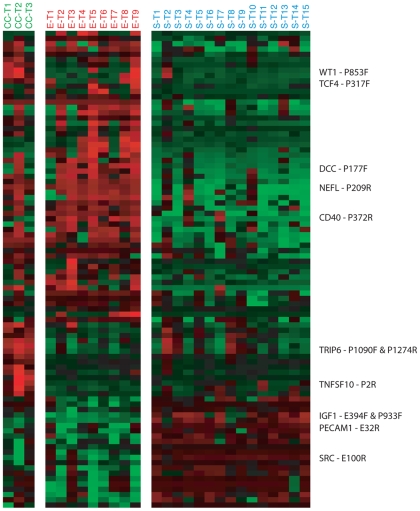
Differential DNA methylation among ovarian tumor histologies.DNA methylation levels are shown for the 90 autosomal CpG sites (68 genes) with a significant difference in methylation between one or more pairs of tumor histologies. Methylation values (β-values) were mean centered for each gene (across tumors). Data were hierarchically clustered only for the CpG sites. The displayed CpG sites were selected based on the adjusted p-values associated with differential expression between tumors and cell lines. Red indicates high methylation relative to the site-specific mean, green indicates low methylation relative to the mean. Rows of data corresponding to sites with the greatest magnitude of difference in methylation levels (β-values) between pairs of tumor histologies are labeled (up to 3 sites in each direction for each pairwise comparison). S = Serous tumor, E = Endometrioid tumor, CC = Clear cell tumor.